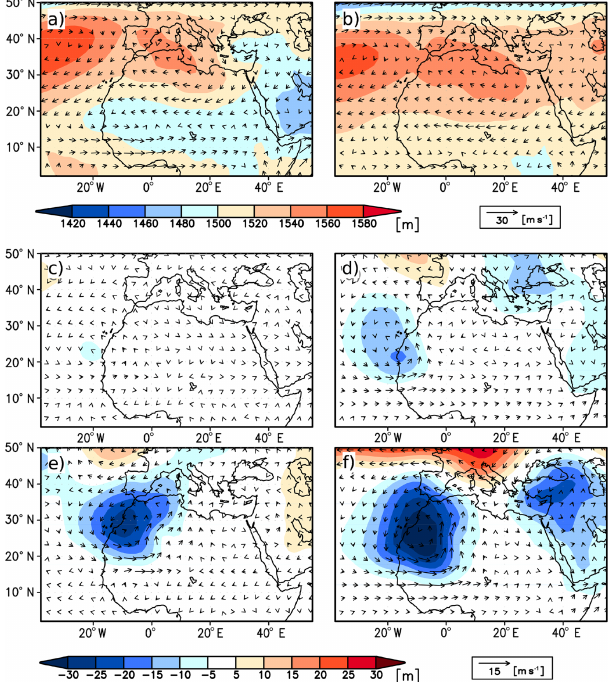
Figure A2. Monthly mean geopotential height at 600hPa (m, shaded) and wind at 600hPa (ms − 1 , vector) for (a) 7ka Septem- ber and (b) 7ka October. (c, d) Differences in 600hPa geopoten- tial height (m, shaded) and 600hPa wind (ms − 1 , vector) between the composite of all rain events occurring in the coastal area (15– 11 ◦ W, 20–25 ◦ N) and the monthly mean flow for (c) 7ka Septem- ber, (d) 7ka October; (e, f) differences between the composite of all rain events in the western Sahara (20–35 ◦ N, 10 ◦ W–10 ◦ E) and the monthly mean flow for (e) 7ka September and (f) 7ka October. The months have been adjusted to the fixed-angular calendar.